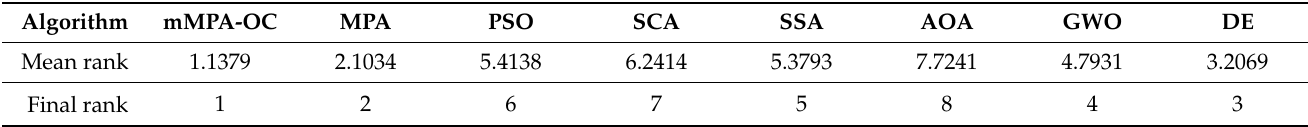
Table 7. Average ranking of the Friedman test on CEC-2017 (10